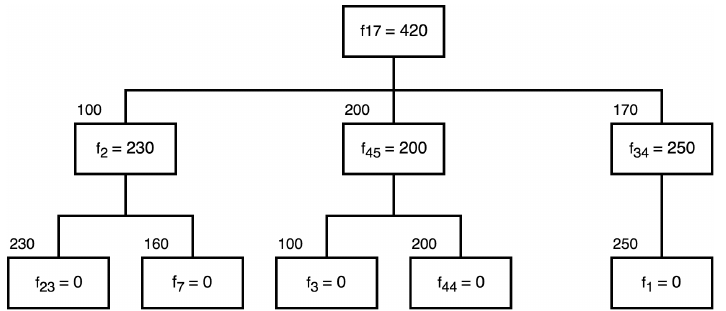
Figure 3. Example of waiting time propagation in an application